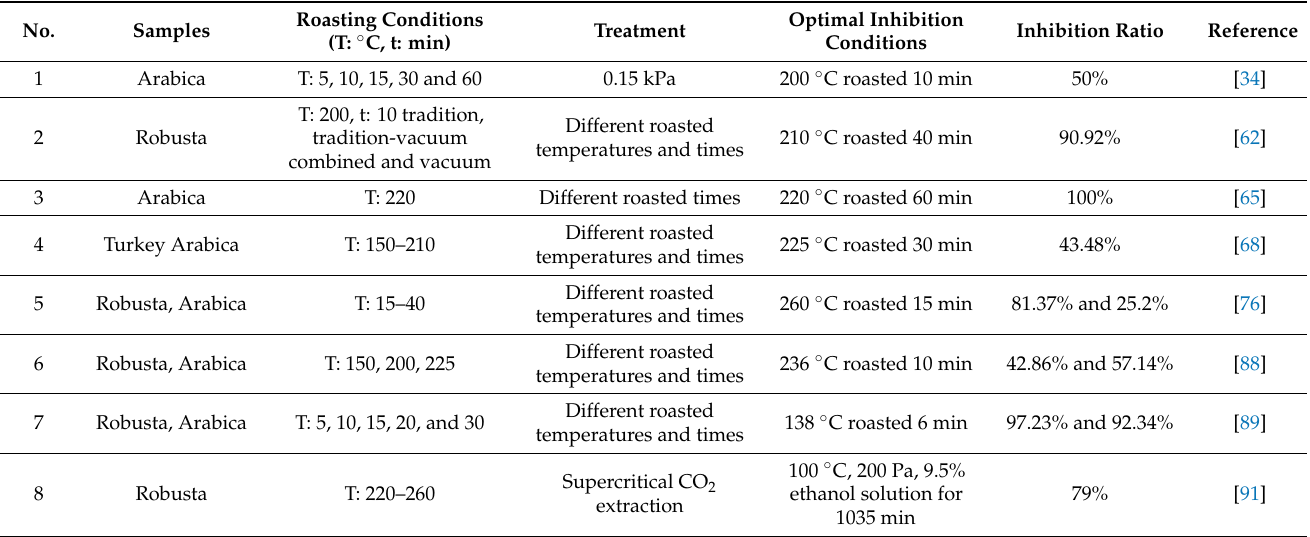
Table 2. Study on the inhibitory effect and strategy of AA in coffee during